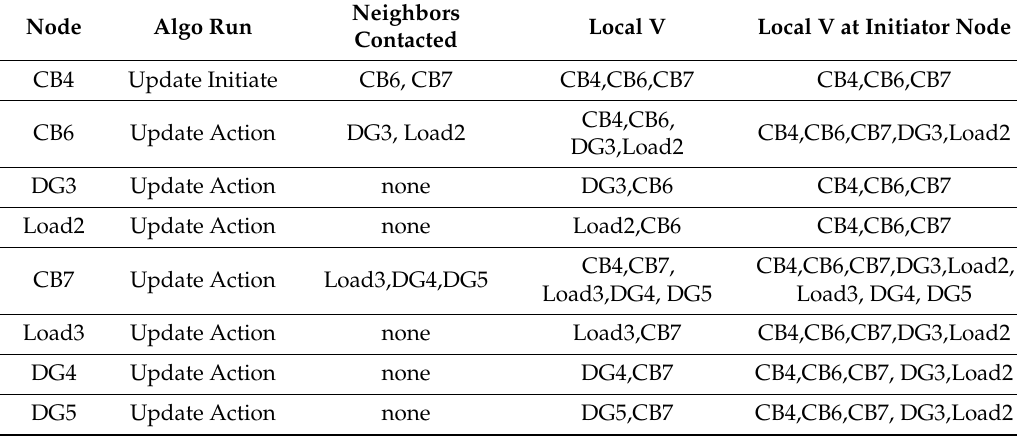
Table 3. Application of update algorithm on CB4.